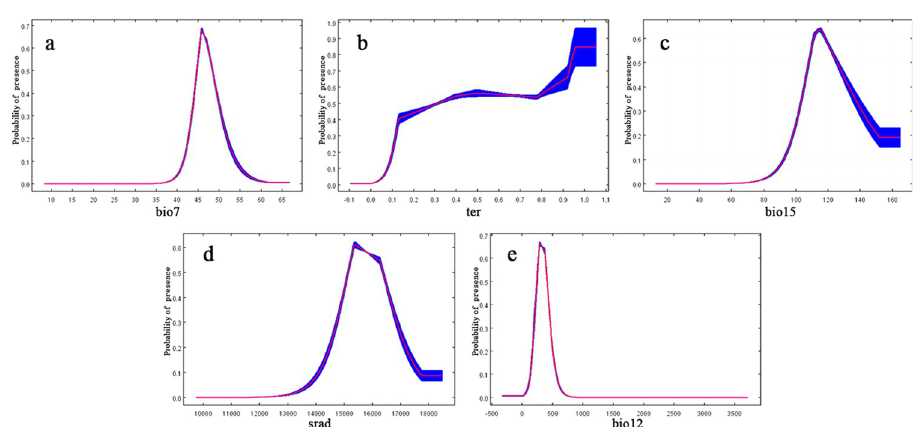
Fig 4. Response curves for important environmental predictors in the species distribution model for E .